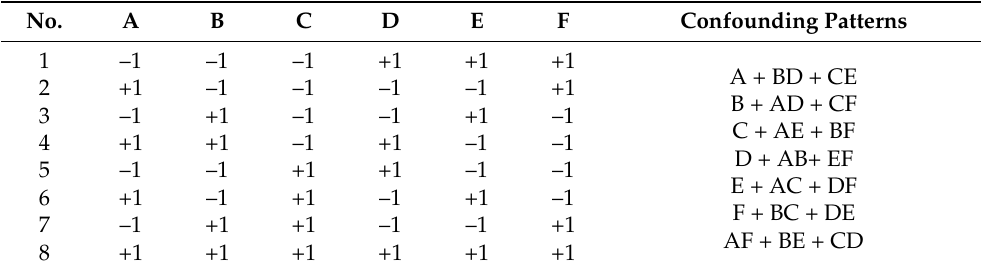
Table 4. Matrix of experiments.